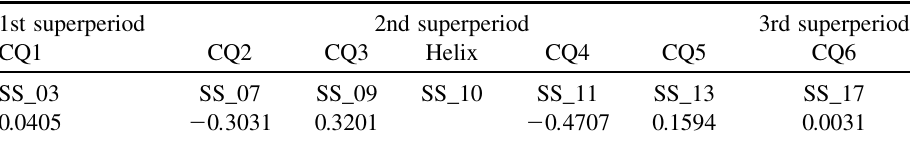
TABLE III. The strength in m (cid:1) 2 (4th row) and the location of the compensation quadrupoles (3rd row) relative to the location of the helical magnet for each of the three superperiod sections of the